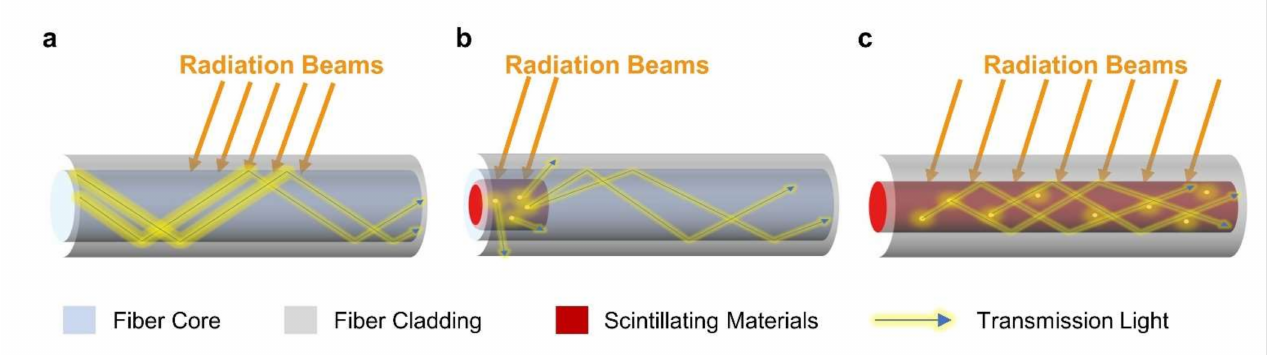
Figure 2. Sensing principles of extrinsic and intrinsic optical fiber radiation sensors. ( a ) Radiation- induced attenuation based optical fiber radiation sensor. ( b ) Radiation-induced luminescence based optical fiber radiation sensor with extrinsic scintillator. ( c ) Radiation-induced luminescence based optical fiber radiation sensor with a scintillating fiber